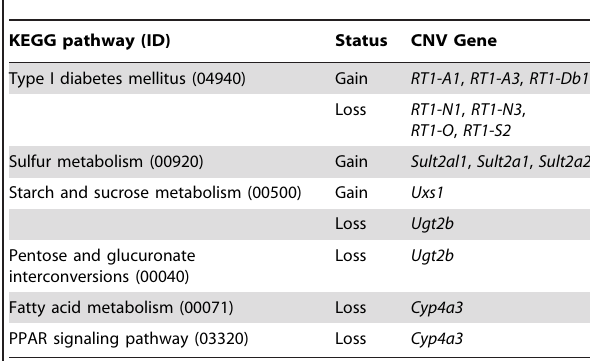
Table 2. Selected GK/Wistar CNV genes involved in diabetes-related